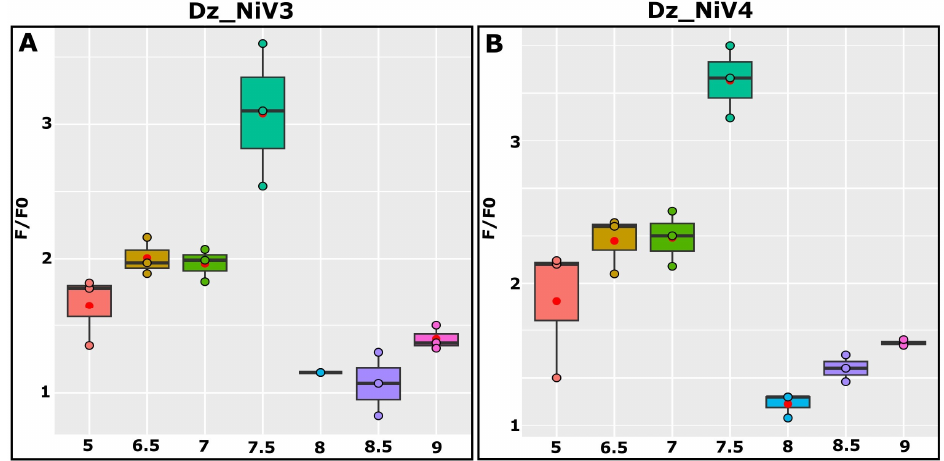
Figure 4. The assessment of pH effects on Dz_NiV3- ( A ) and Dz_NiV4 ( B )-based biosensor efficiencies. The red dots on the graphs indicate mean values.